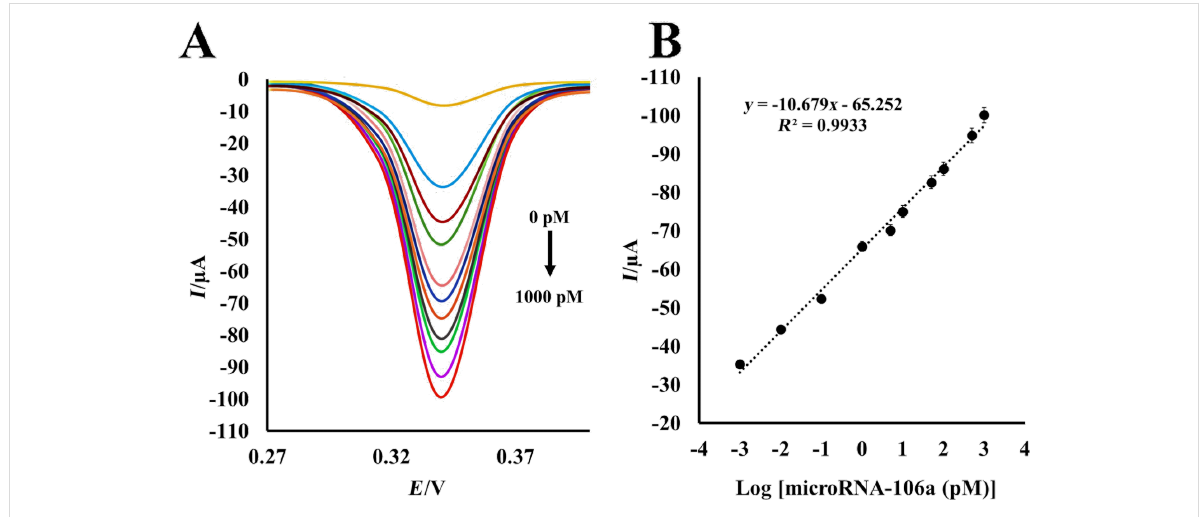
Figure 4: (A) Differential pulse voltammograms for the electrochemical detection of miR-106a upon serial dilutions of target miR-106a at scan rate 100 mV/s in 1 M HCl. The concentrations of target miRNA are: 0, 0.001, 0.01, 0.1, 1, 5, 10, 50, 100, 500, and 1000 pM. (B) The calibration curve of miR-106a as the relationship between current and logarithm of miR-106a concentration. Each data point is the average of five